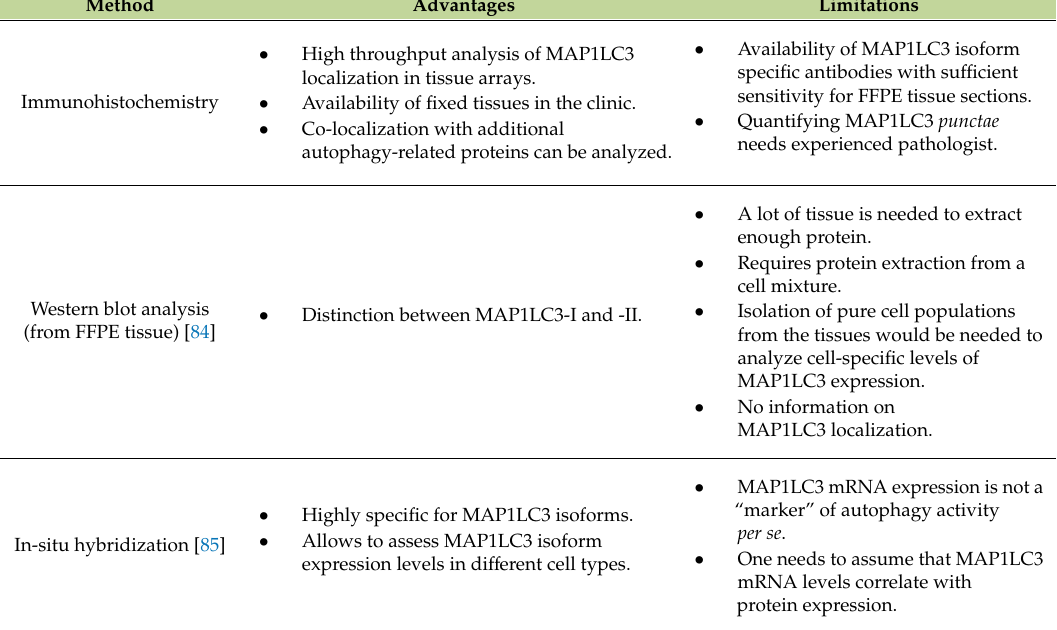
Table 3. MAP1LC3-based methods to measure autophagy in